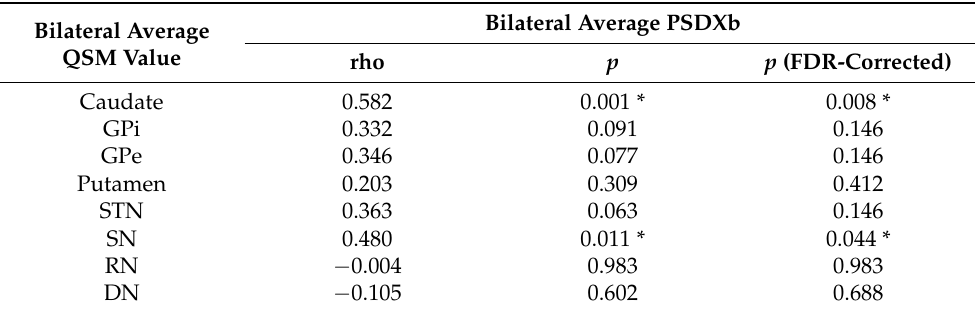
Table 2. Results of the correlation analysis between the bilateral average PSDXb and bilateral average QSM values in DGM structures.